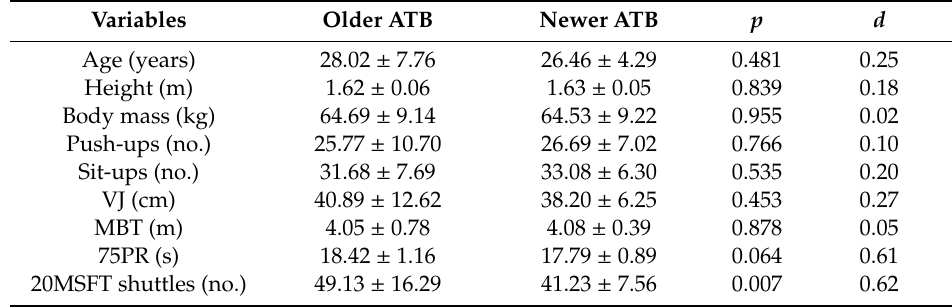
Table 3. Descriptive and fitness testing data from female recruits hired under an older ATB ( n = 84), versus one class hired under the LEA’s newer ATB ( n =